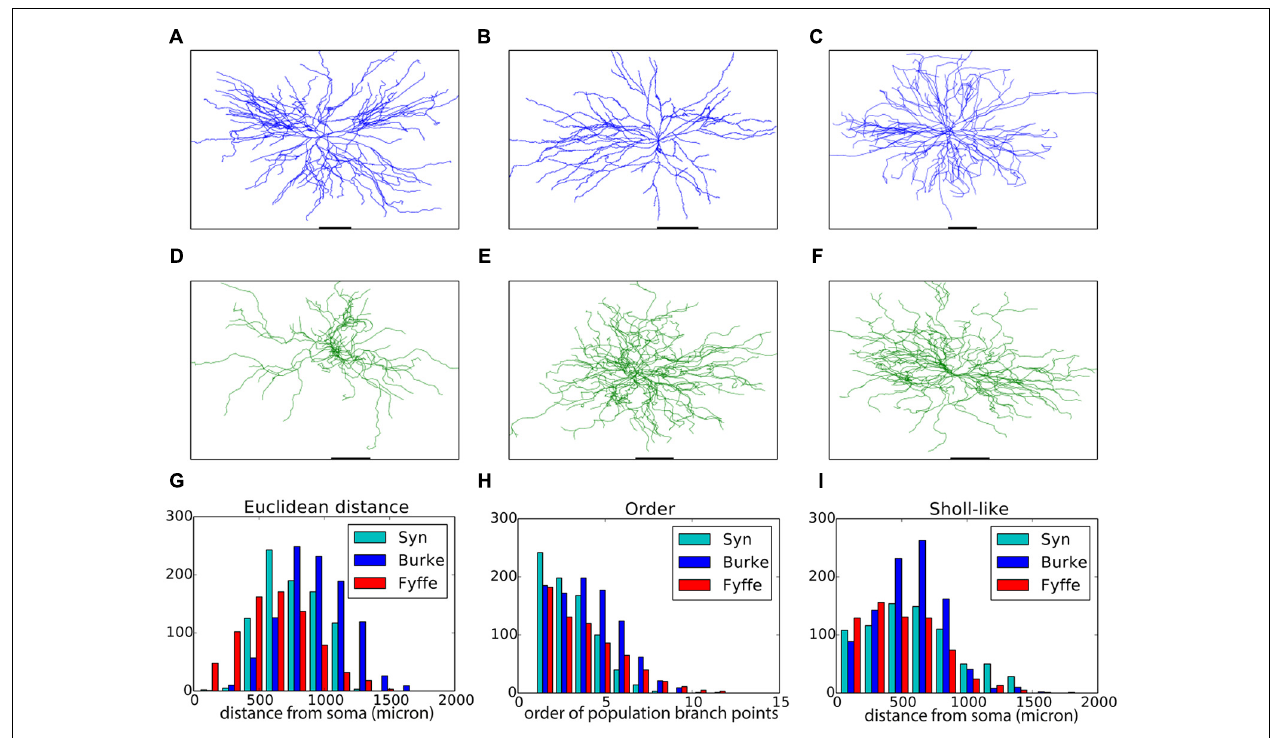
FIGURE 2 |Validation of generated alpha motor neurons. (A–C) Exemplar experimentally reconstructed spinal cord alpha motor neurons [ A,B from the Fyffe archive (Alvarez etal., 1998), C from the Burke archive (Cullheim etal., 1987)]. (D–F) Virtual morphologies generated by NeuroMaC. (G–I) Quantitative comparison. Population morphometrics are shown for the Burke (“Burke”) and Fyffe (“Fyffe”) archives and for the